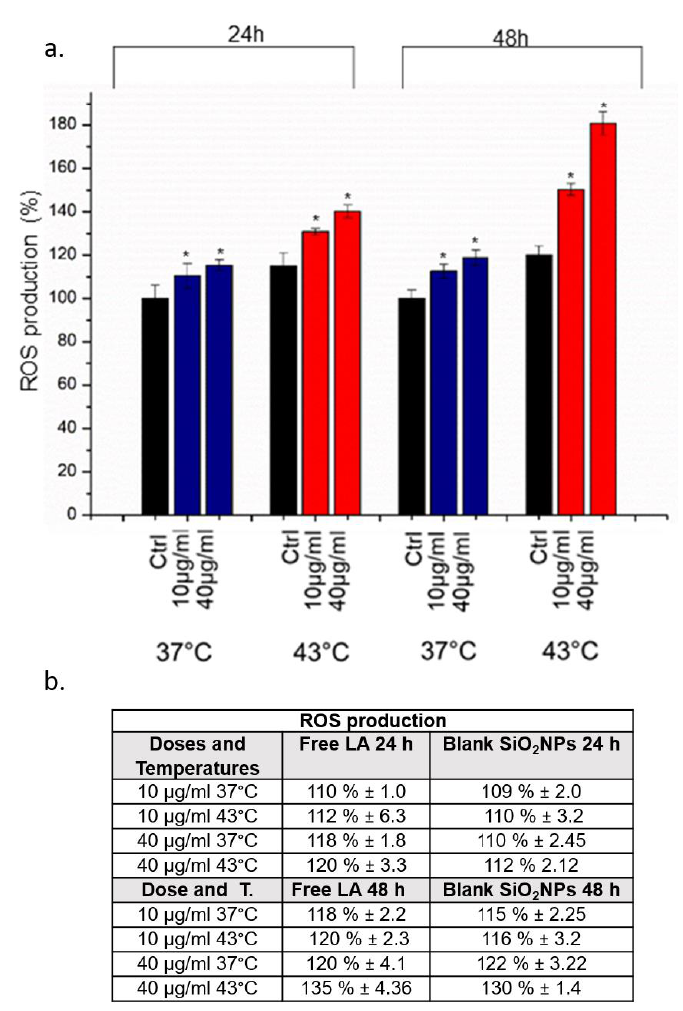
Figure 6. a . Effect of SiO 2 @LA NPs on the reactive oxygen species (ROS) level in MCF-7 cells. Cells were treated with of 10 µg/mL and 40 µg/m of NPs for 24 h and 48 h at 37 °C and 43 °C incubated with 100 µM DCFH-DA. Cells fluorescence was measured. Controls sample were represented by cells without SiO 2 @LA NPs exposure. As a positive control (P), cells were incubated with 500 µM H 2 O 2 showing a ca. 300% DCFH-DA increase (not show). b . ROS values expressed in percentage obtained on MCF-7 cells after 24 h and 48 h exposure to 10 µg/mL and 40 µg/mL of blank SiO 2 NPs and free LA at 37 ◦ C and 43 ◦ C. Data reported as mean ± SD from three independent experiments are considered statistically significant compared with control ( n = 8) for p value < 0.05, ( < 0.05